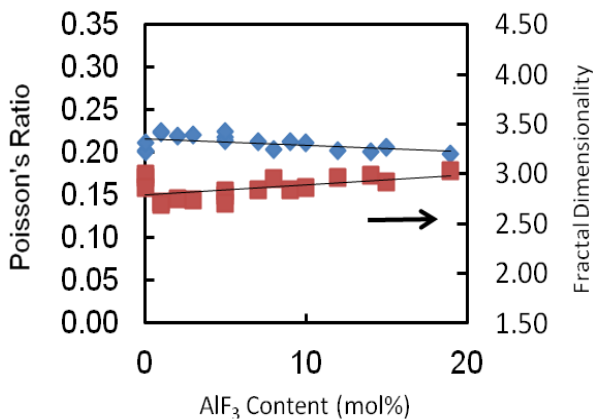
Figure 6. Poisson ratio and fractal dimensionality of AlF drawn to guide the